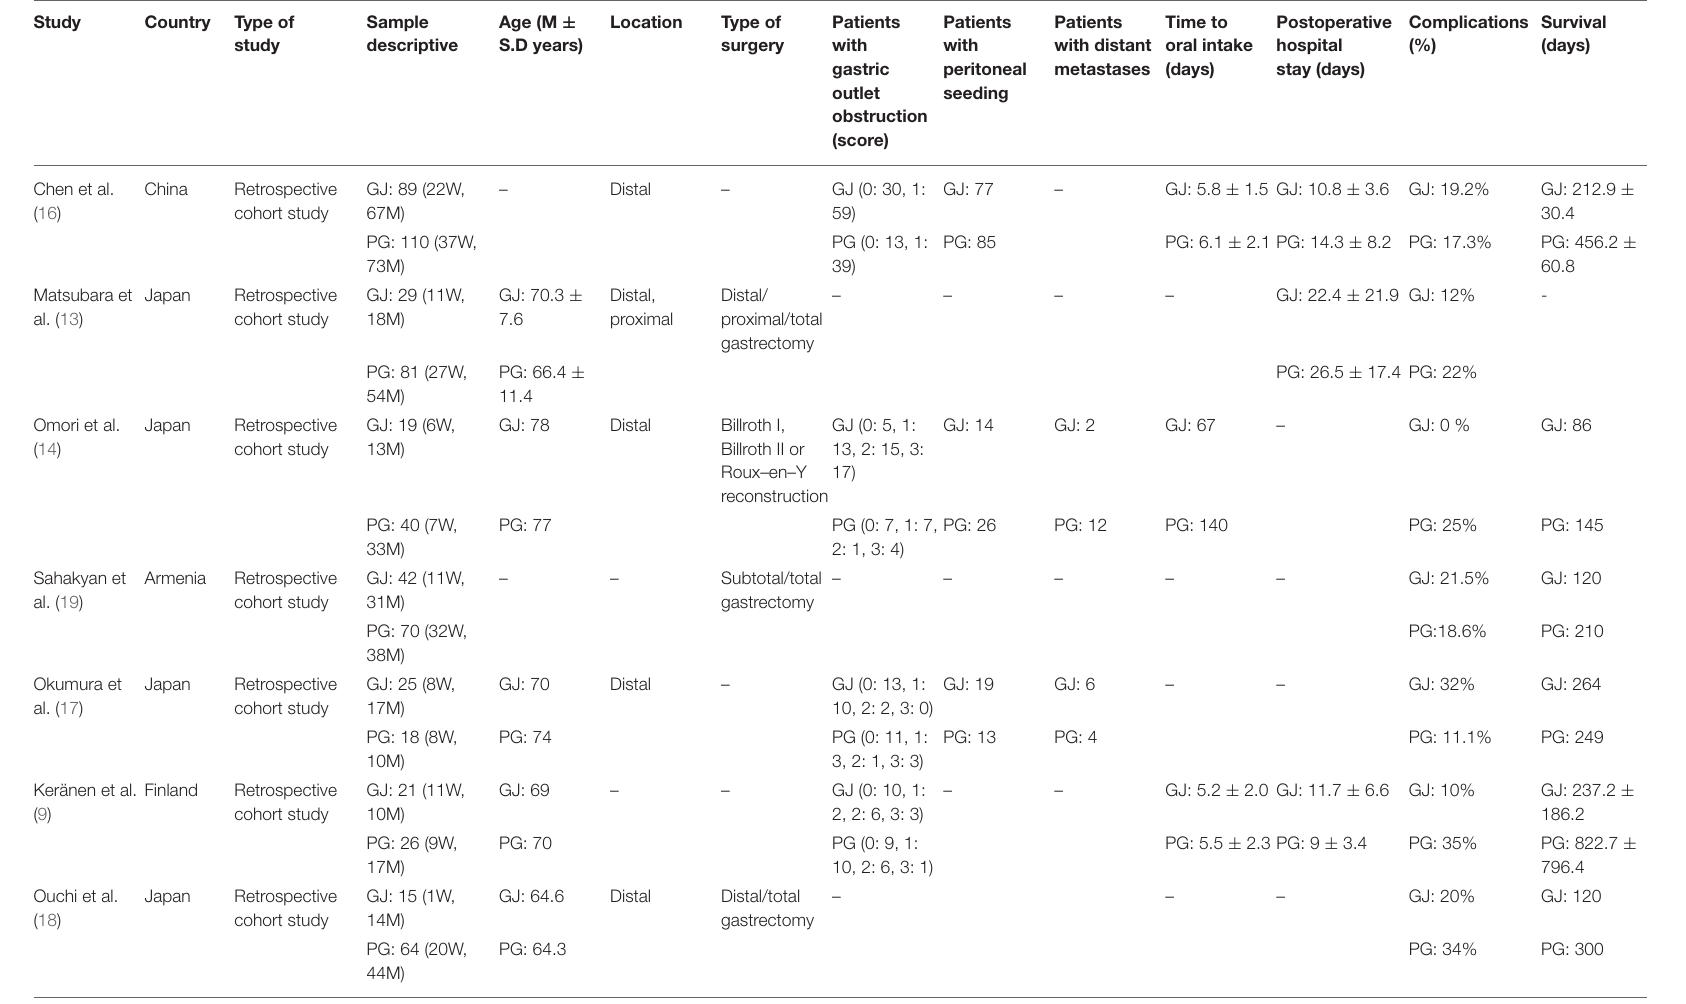
TABLE 1 | Details of the included